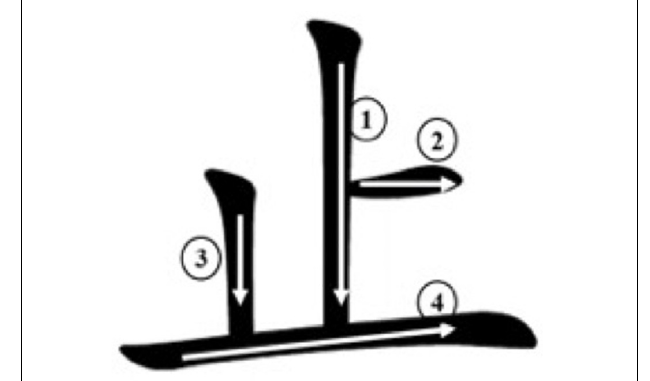
FIGURE 1 | The stoke order of the Chinese character 止止 /zhi3/